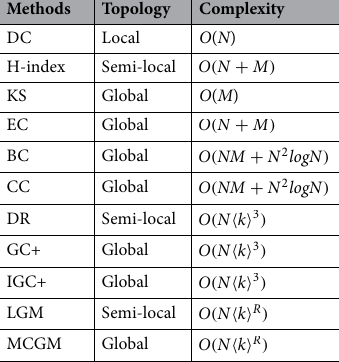
Table 8. The computational complexity of MCGM and the benchmark algorithms.